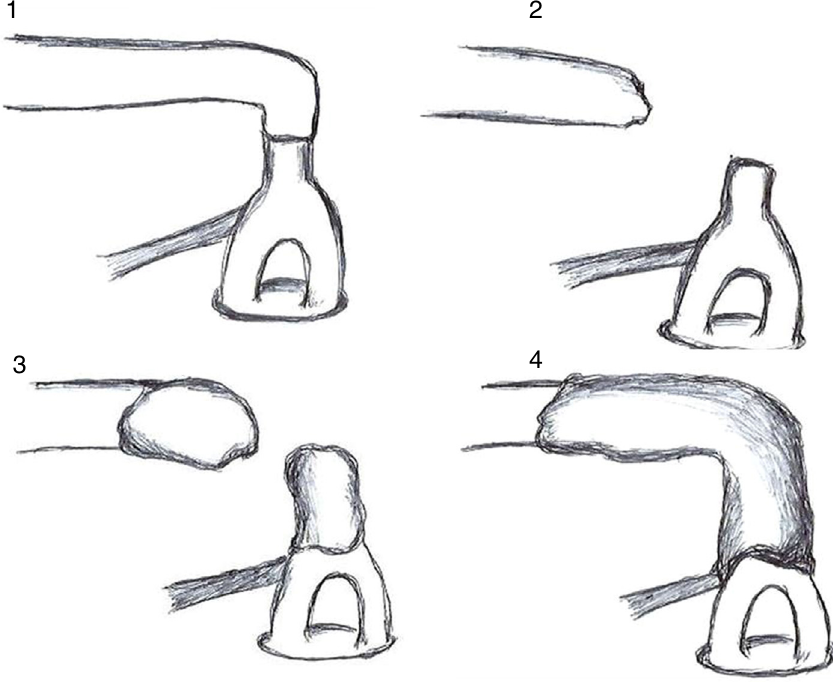
Figure 1 Schematic drawing of the four attempts at ossicular chain reconstruction with resin